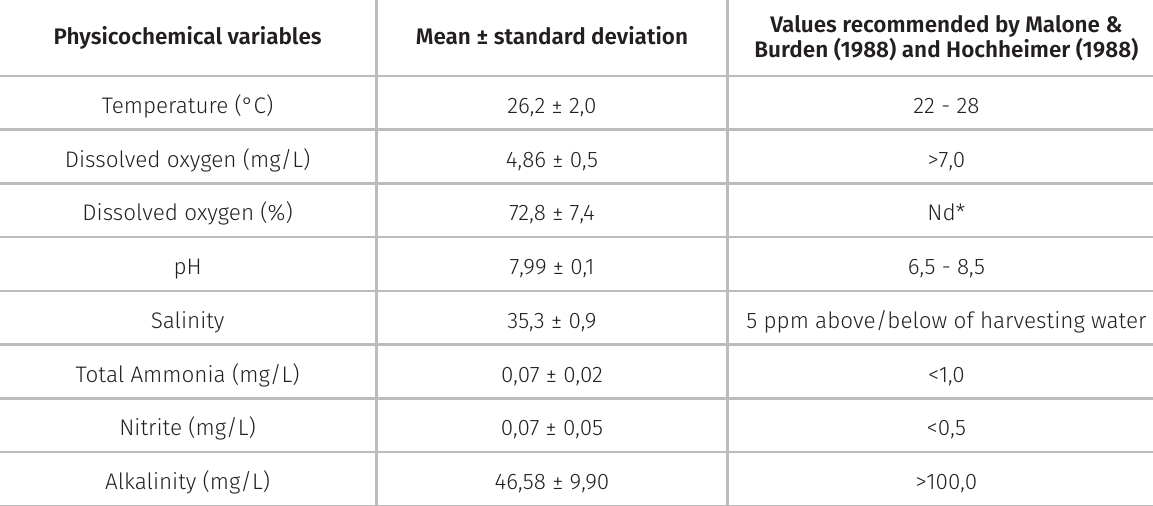
Values recommended by Malone & Burden (1988) and Hochheimer